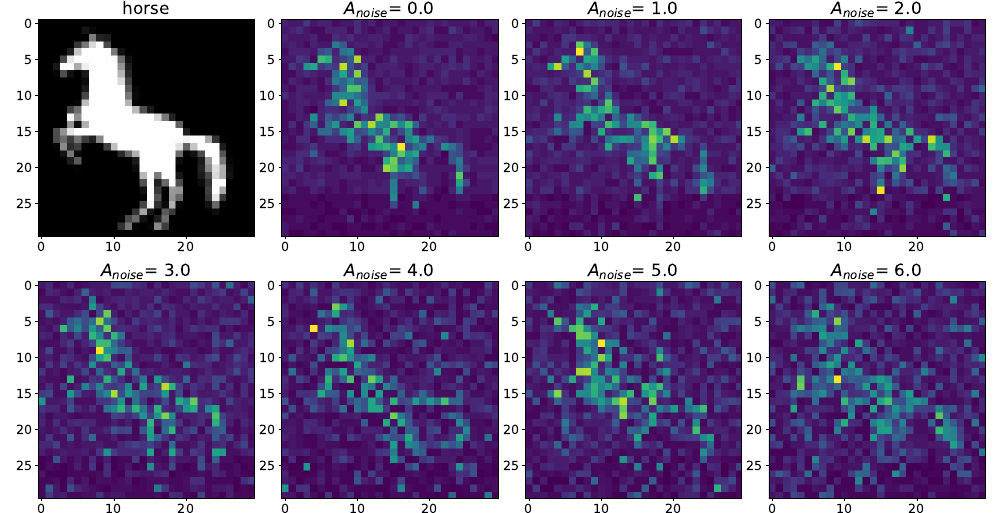
Figure 6. Changes in the spatial sweep of the spiking neural network during the representation of the supplied image from Figure 2 when the amplitude, A noise , of the noise current, I noise , changes from 0 to 6 with modulation of neuronal activity by